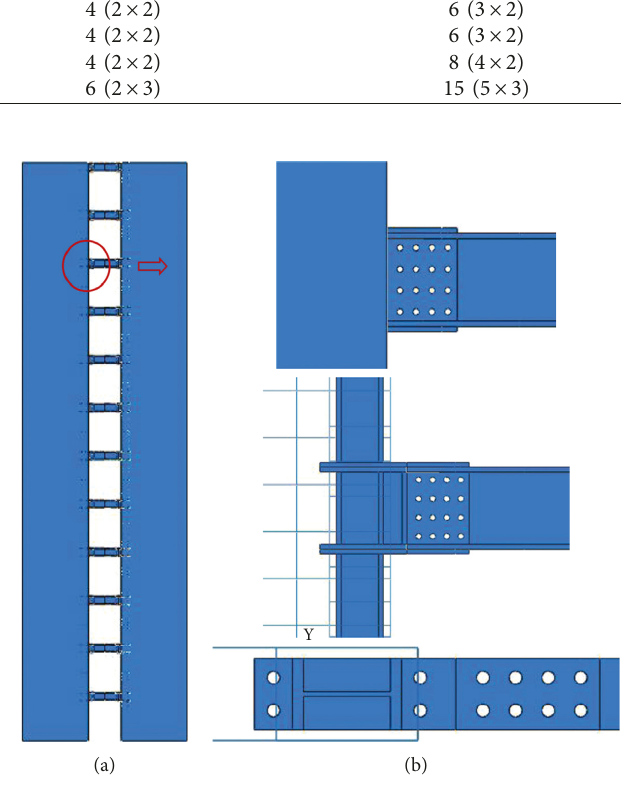
Figure 8: (a) FEA model. (b) Connection details of FEA